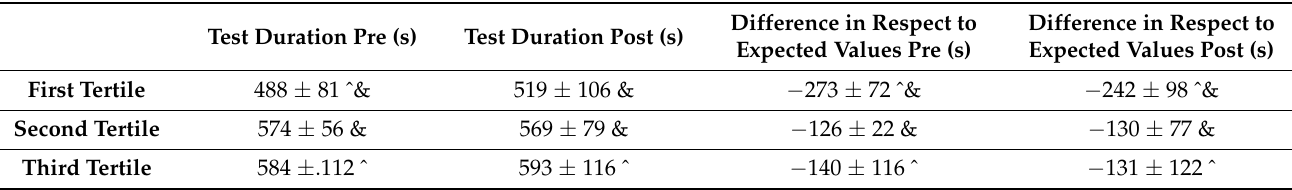
Table 3. Bruce protocol test duration in a group of young subjects with congenital heart disease compared to what has been reported in the literature for healthy subjects of the same age (25) . The overall group was divided into tertiles based on the expected test duration (the first tertile has the lowest exercise